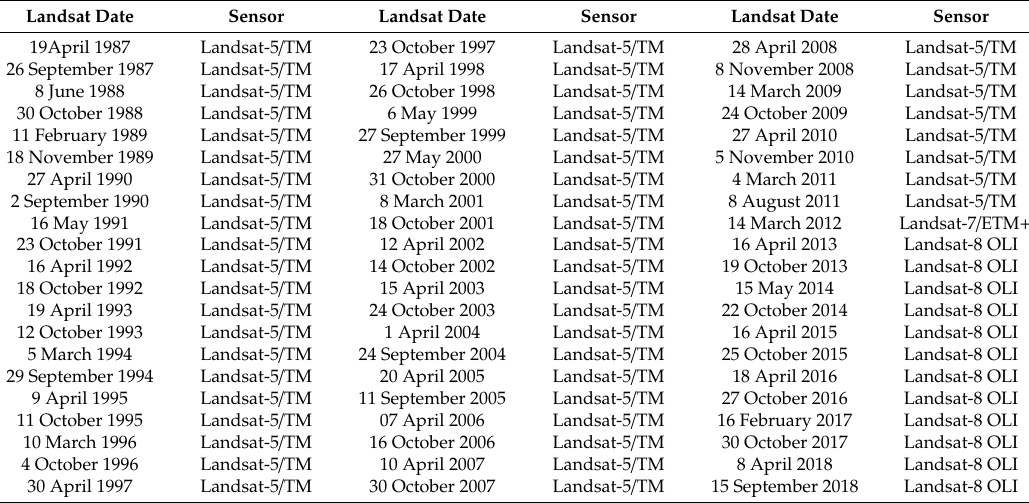
Table 1. Landsat image acquisition date and sensor